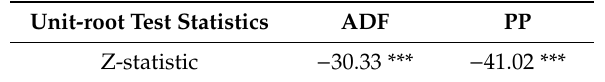
Table 4. Unit-root test results on residuals of the time-varying cointegration equation. ADF—Augmented Dickey–Fuller, PP—Phillips–Perron.